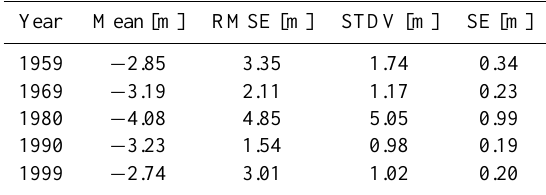
Table 2. Validation of DEMs against 26 independent dGPS points. For the statistics given, the elevation of the dGPS points is sub- tracted from the elevation of the DEMs. The spatial distribution of the dGPS points is shown in Fig.